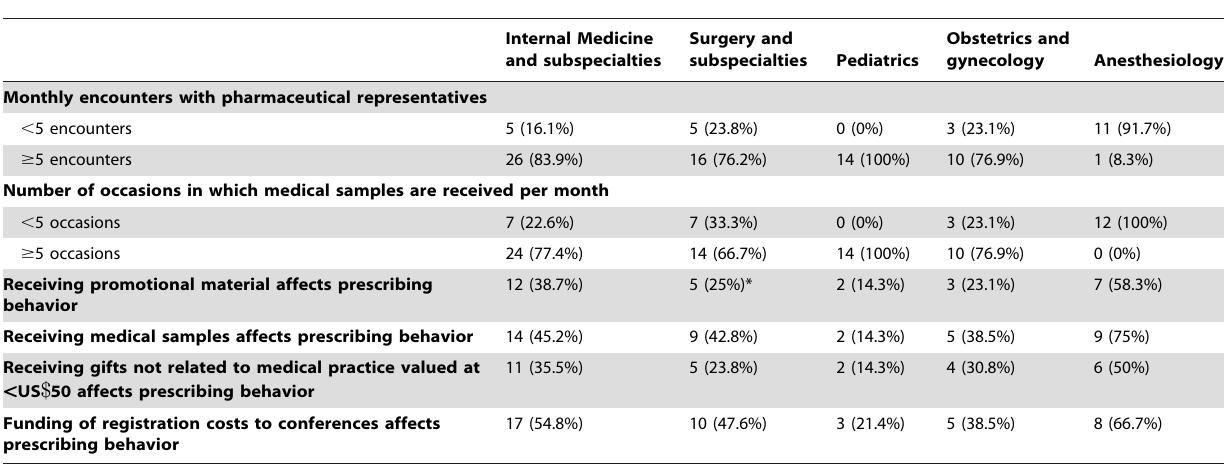
Table 5. Participation of attendings in activities and acceptance of gifts from industry stratified by specialty.